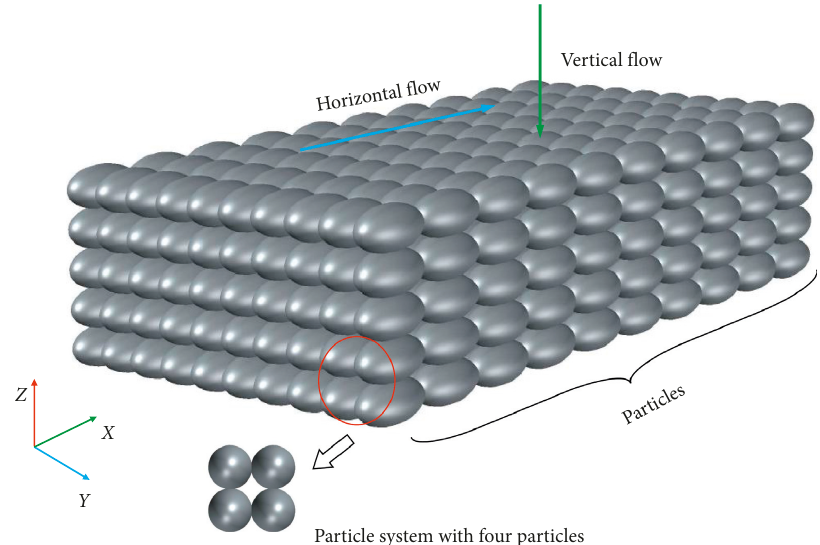
Figure 2: Overall distribution of soil particles. The figure mainly shows the soil layer which constitutes of four-particle